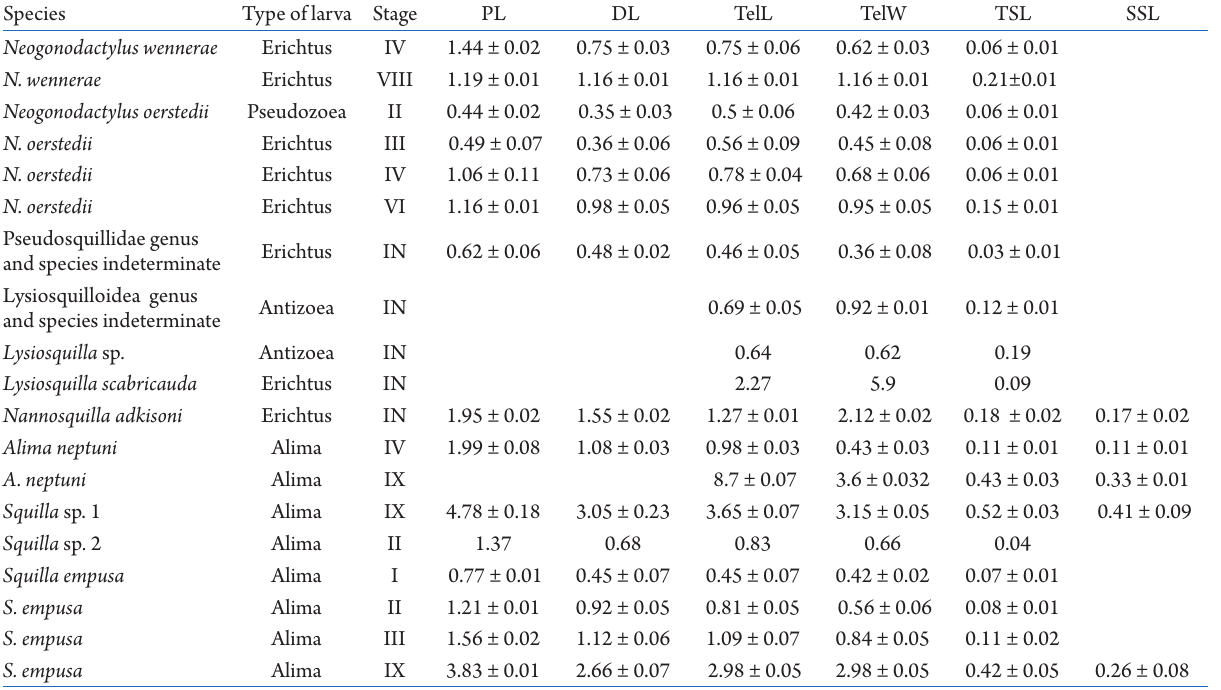
Table 2. Stomatopod larvae collected at the national parks Sistema Arrecifal Veracruzano (SAVNP) and Arrecife Puerto Morelos (APMNP) organized by species, larval stage, and type of larva. PL, propodus length; DL, dactylus length, TelL, telson length (TelL); Telw, telson width; TSL, telson lateral spines length; SSL, telson submedian spines length.